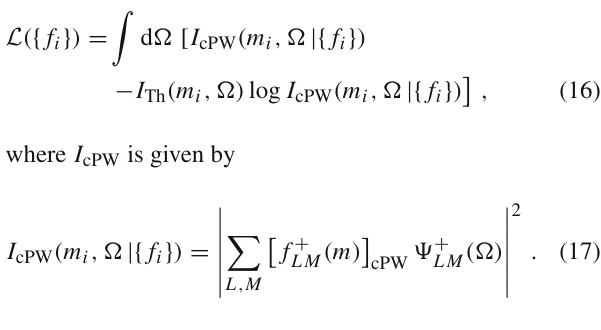
plicity, we consider I Th ( m , (cid:4)) of Eq. (7), as obtained from MVR. We follow the conventions in Eq. (2). For each energy bin m i , we extract the constrained partial waves (cPW) by minimizing the ENLL